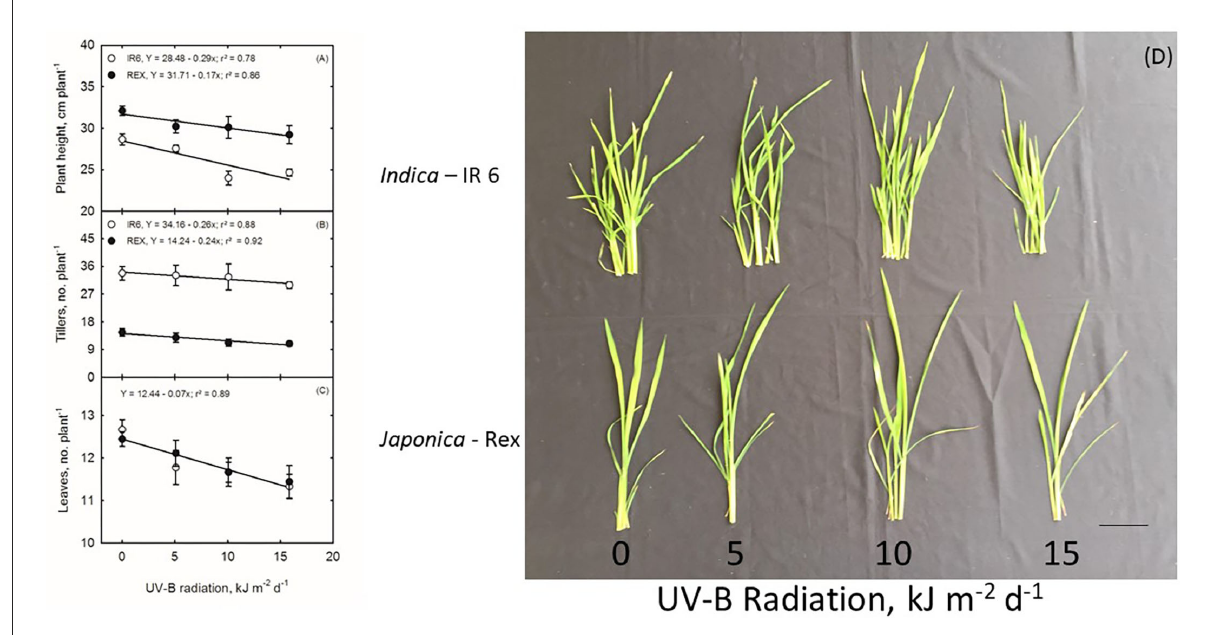
FIGURE1 (A–D) Ultraviolet-B Effects on Rice Plants. Scale bar 2